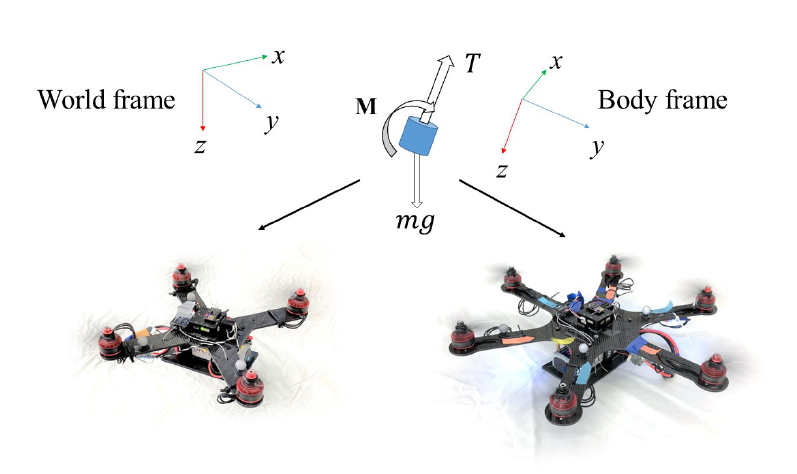
Figure 1. Single trained RL controller from 6DoF model with thrust T and moment M to different- configuration